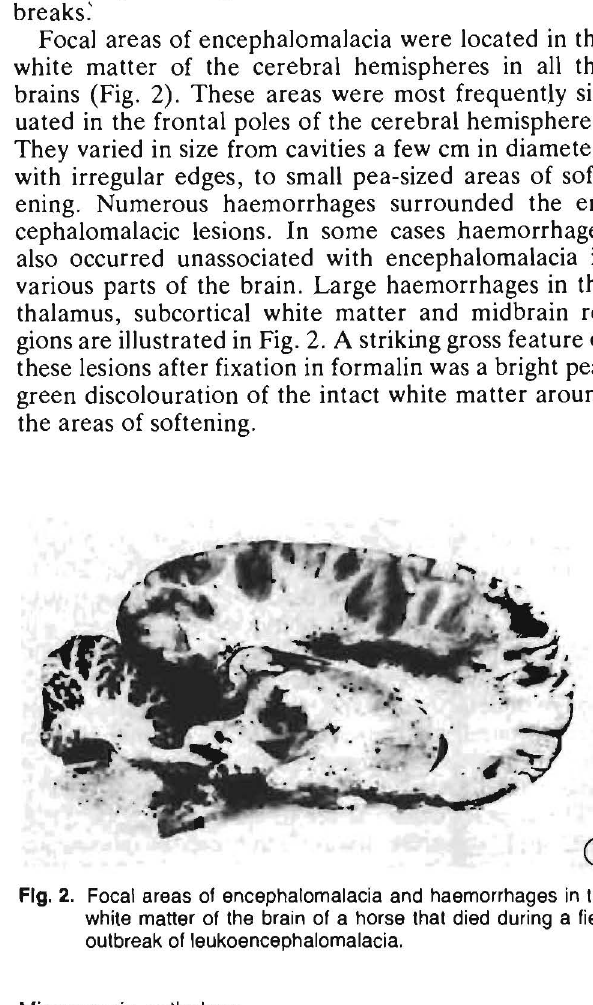
Fig. 2. Focal areas of encephalomalacia and haemorrhages in the white matter of the brain of a horse that died during a field outbreak of